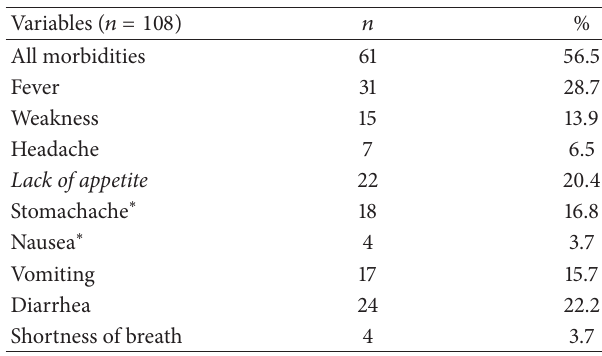
Table 3: Frequency of referred morbidities in the previous 30